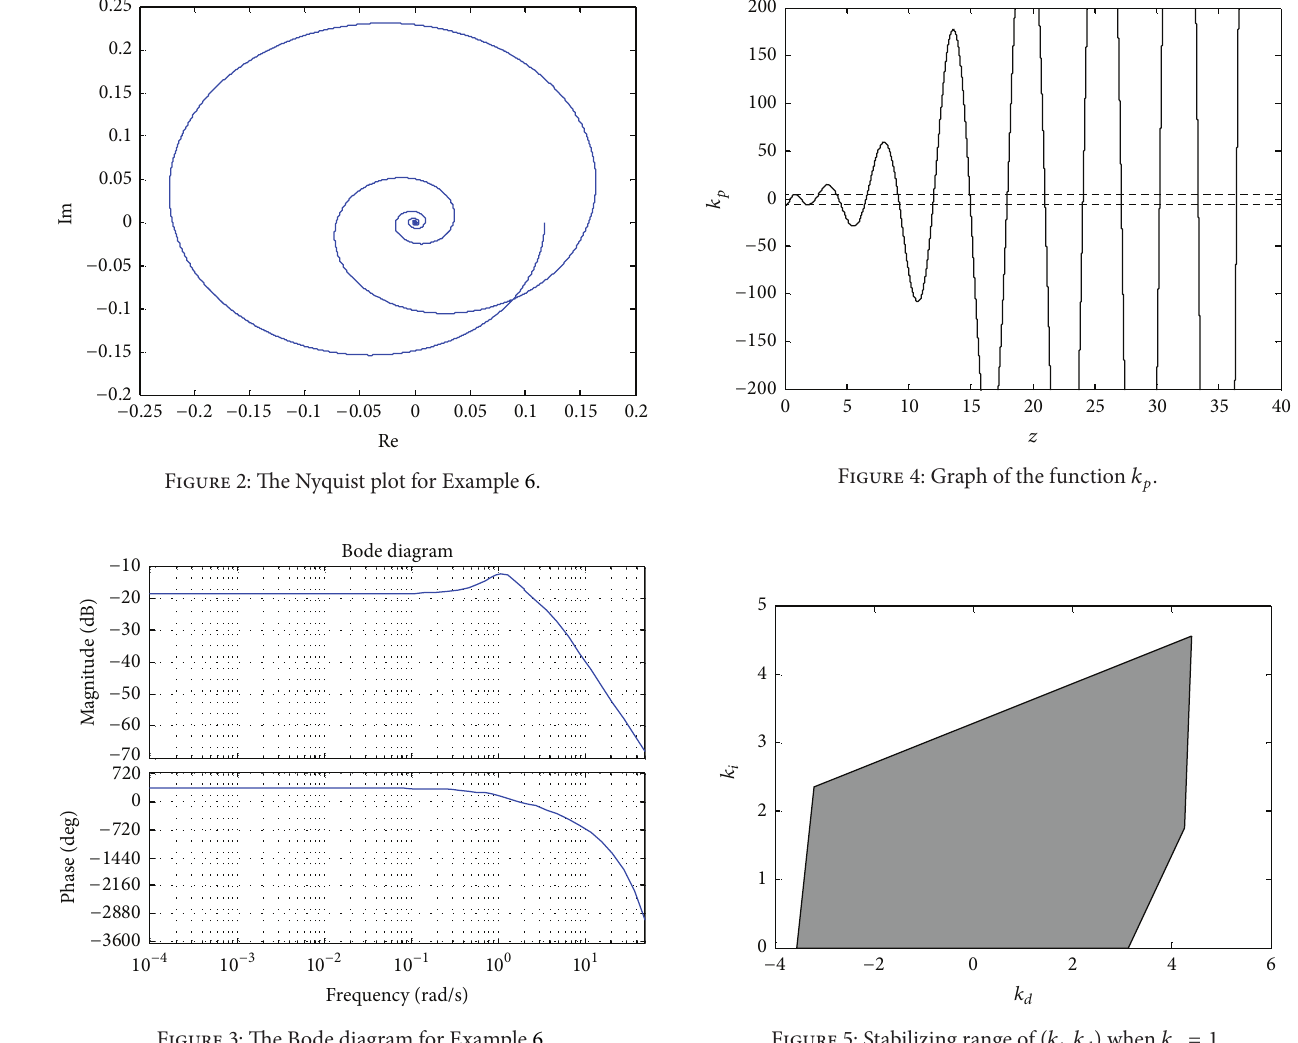
Figure 5: Stabilizing range of (𝑘 𝑖 , 𝑘 𝑑 ) when 𝑘 𝑝 = 1 .